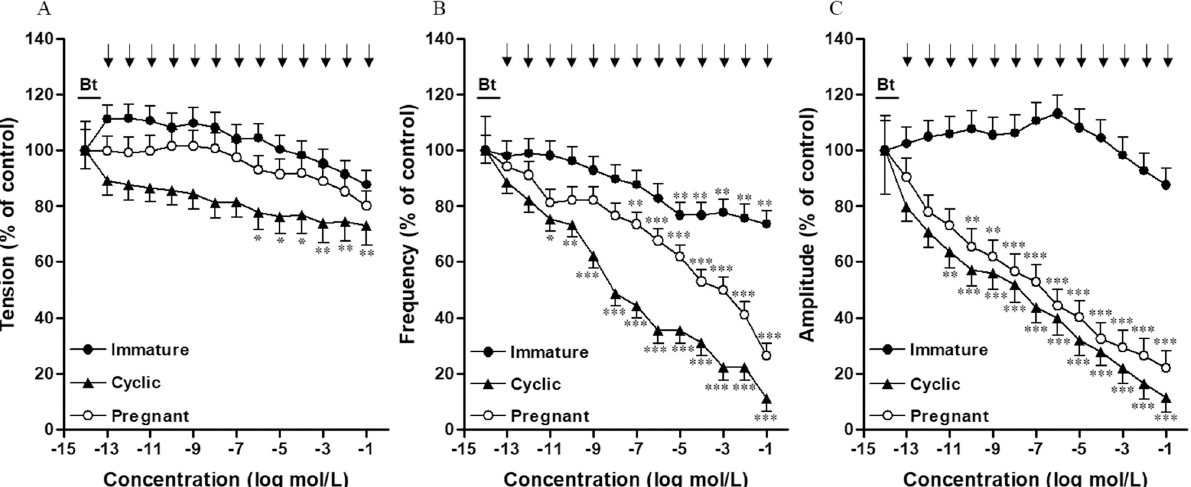
Fig 2. Effect of Que on uterine contractions. Effect of quercetin (Que) on tension (A), frequency (B) and amplitude (C) of contractions of myometrium in immature pigs (- ● -; n = 6) and on days 12–14 of the oestrous cycle (- ▲ -; n = 6) and 12–16 of pregnancy (- � -; n = 6). The results calculated for a 15 min period after treatment with each quercetin concentration were expressed as a percentage (mean ± SD) of the amplitude, frequency and tension determined for a 15 min period before treatment (Bt). � p < 0.05, �� p < 0.01, ��� p < 0.001 –significant differences as compared to the contractile activity before the